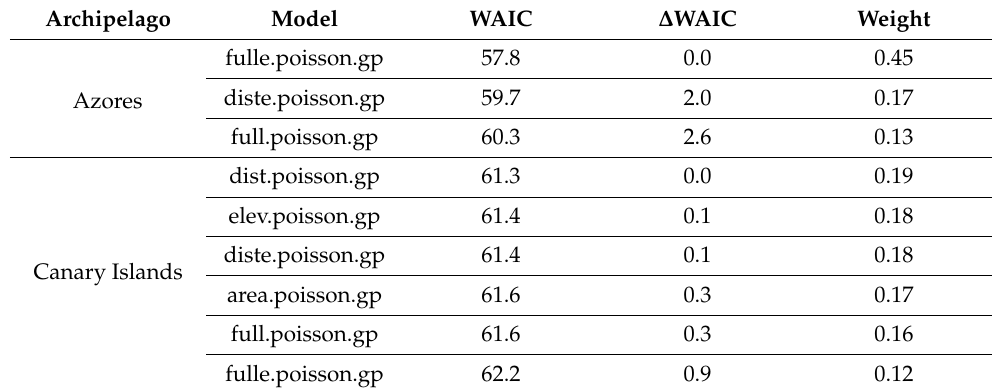
Table 9. Comparison of the several models using the “Widely Applicable Information Criterion” (WAIC) criterion for the single island endemic species (SIE). Only models with ‘weight’ greater than 0.01 are shown. See the captions of Tables 3 and 6 for the explanation of the acronyms. Archipelago ∆ WAIC